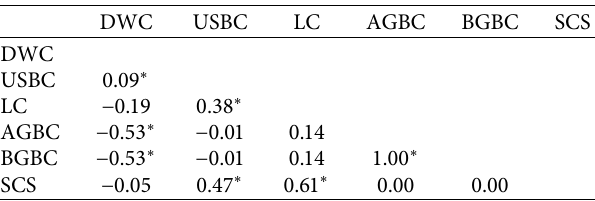
Figure 8: Carbon stock distribution and percent share of each carbon pool in Ziba forest. Table 5: Pearson’s product moment correlation coefficient and P value between carbon pools in Ziba forest.